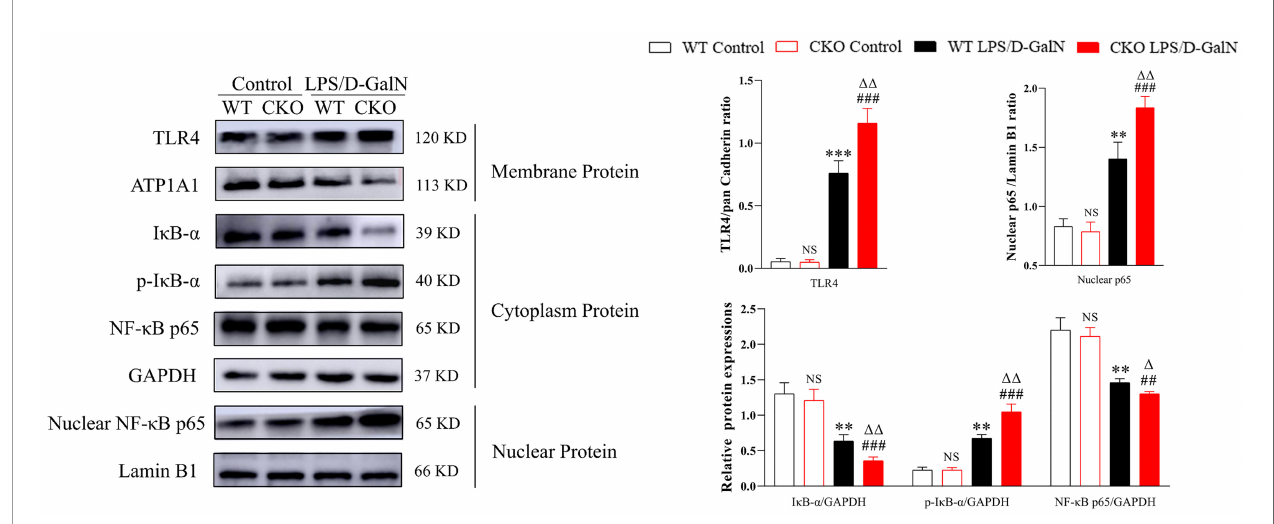
FIGURE 3 | PEBP4 CKO could activate the TLR4/NF- k B signaling pathway. Western blotting was employed to examine the expressions of TLR4, I k B- a , p-I k B- a , nuclear protein NF- k B p65, and cytoplasmic protein NF- k B p65. Data are presented as mean ± SD values (n=3). NS P > 0.05, ** P < 0.01, and *** P < 0.001 compared to the WT control group; ### P < 0.001 compared to the CKO control group; and D P < 0.05 and DD P < 0.01 compared to the WT LPS/D-GalN